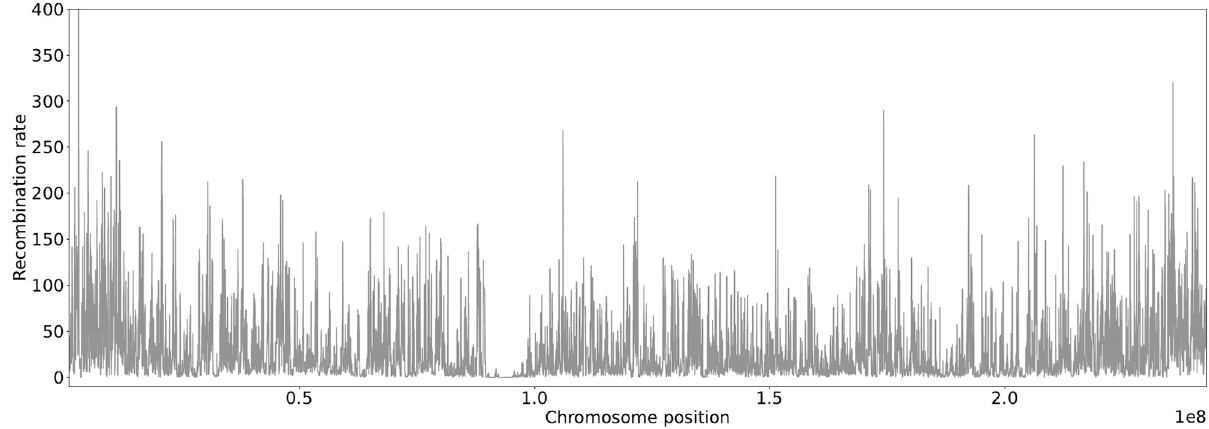
Fig 4. Recombination map for human chr2. Displayed recombination rates along the chromosome are based on a sliding window of 70kb. This also ensures better comparability with Fig 5. The mean recombination rate in the 70kb windows varies along the genome and is on average approximately ρ = 31.